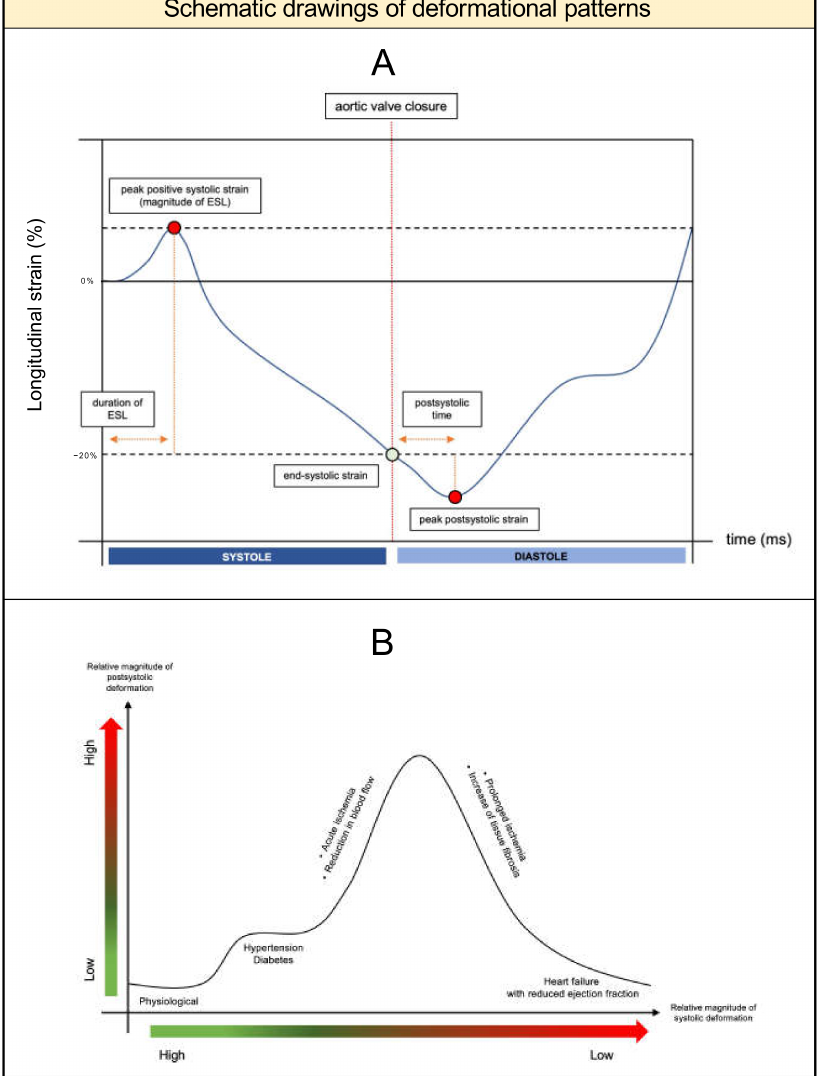
Figure 1. Longitudinal speckle tracking profile and suggested natural history of postsystolic shortening. Legend: ( A ): Schematic drawing of longitudinal speckle tracking profile displaying early systolic lengthen- ing and postsystolic shortening as indicated with red dots. ( B ): Suggested natural history of postsystolic shortening. Relative magnitude of postsystolic shortening throughout different populations as a function of relative magnitude of systolic deformation. ESL: early systolic